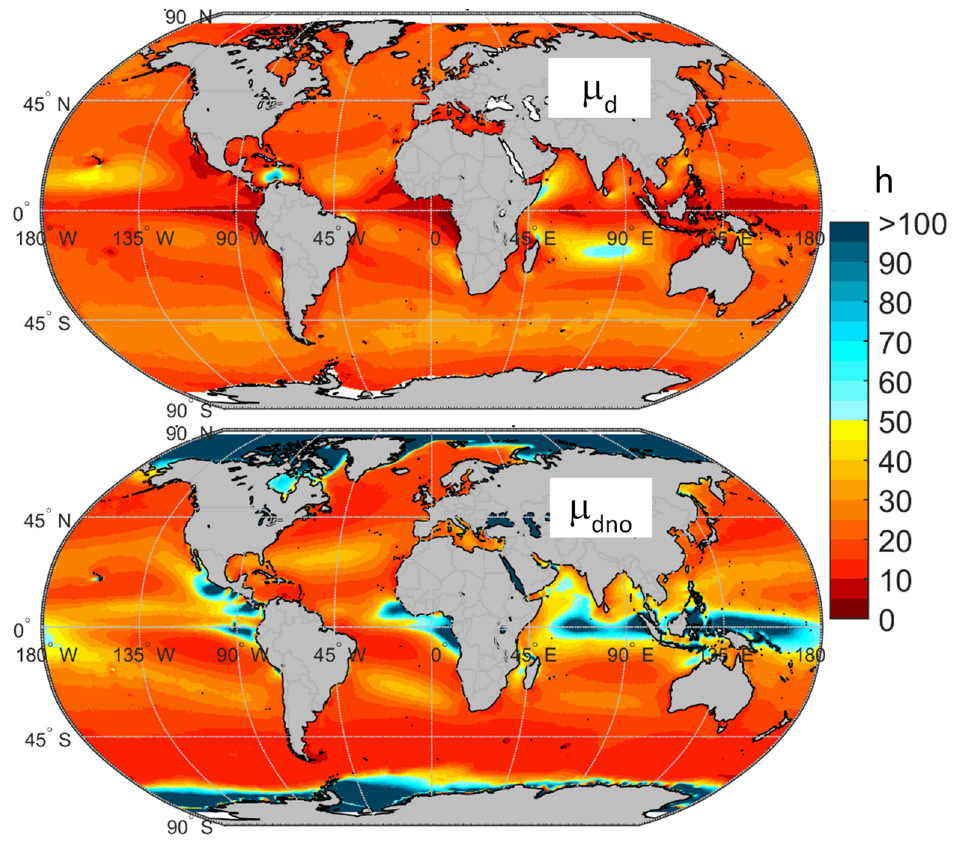
Figure 12. Global distribution of the annual mean duration of operability, µ d (above) and non- operability (below) intervals, µ dno